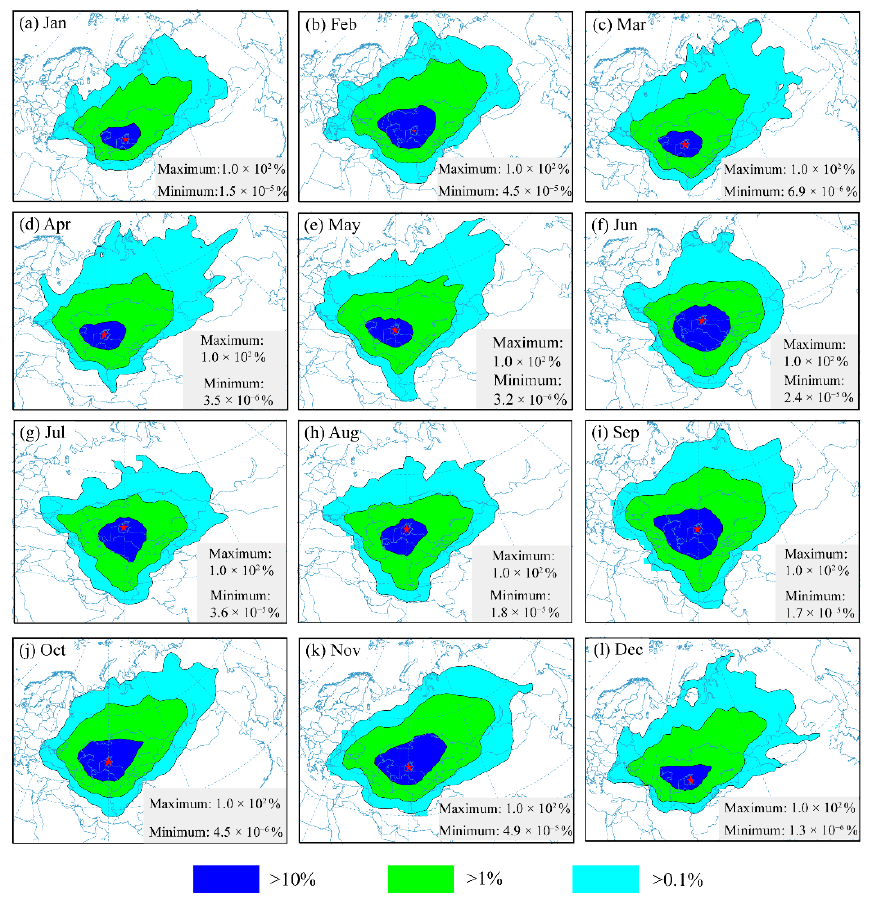
Figure 12. Zone frequently impacted by atmospheric aerosols from the Aral Sea region in different months. The red asterisk indicates the location of the Aral Sea.